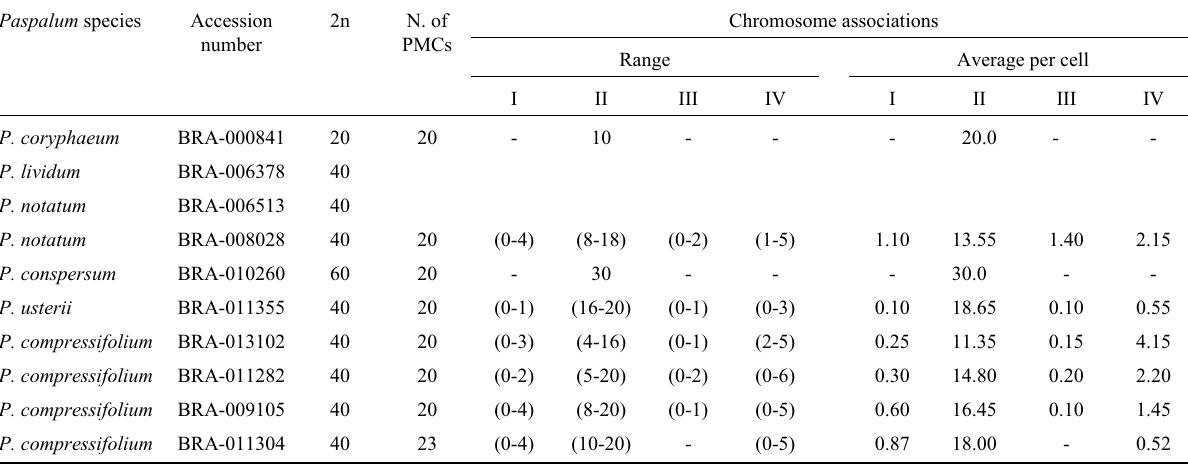
Table 2 - Chromosome numbers and meiotic chromosome associations at